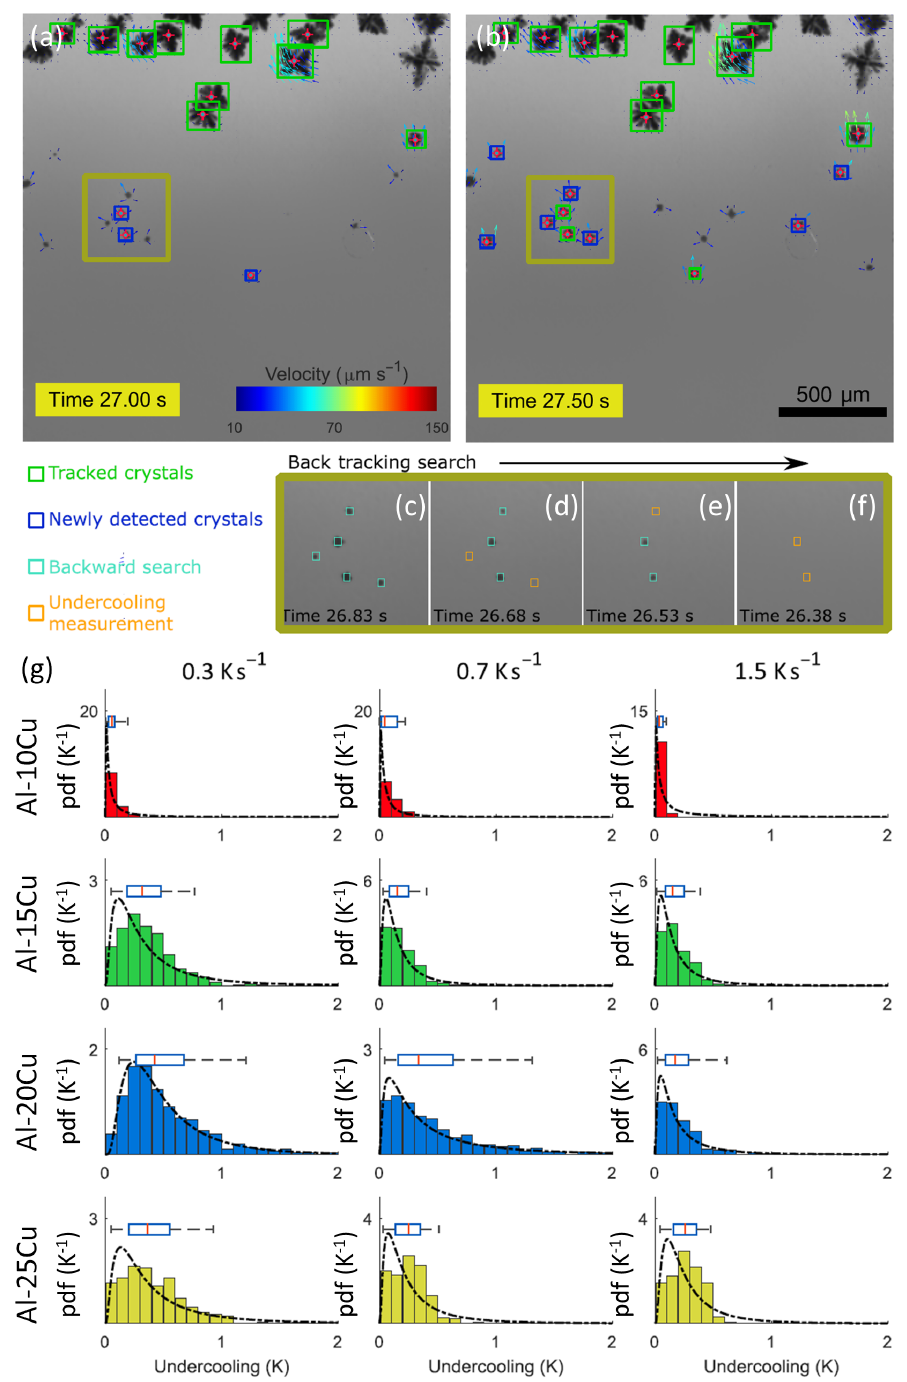
Figure 2. ( a , b ) Radiographs at t = 27 s and t = 27.5 s showing the crystallisation of a TiB 2 inoculated Al-25wt.%Cu alloy. The green boxes indicate grains already identified in earlier frames, blue boxes indicate grains identified for the first time. ( c – f ) A magnified radiograph sequence in reverse time of a cluster of five crystals highlighted by the dark yellow box in ( a , b ), demonstrating the back tracking method for undercooling measurement. ( g ) Distributions of undercooling probability density functions (pdf) for four alloy compositions, each studied at three cooling rates. The box plot in each graph shows the position of the median undercooling (red line), the second and third quartiles (blue box), and the 5 to 95 percentiles (whiskers). The dotted line represents a best-fit log-normal distribution. The data set includes 6200 validated measurements